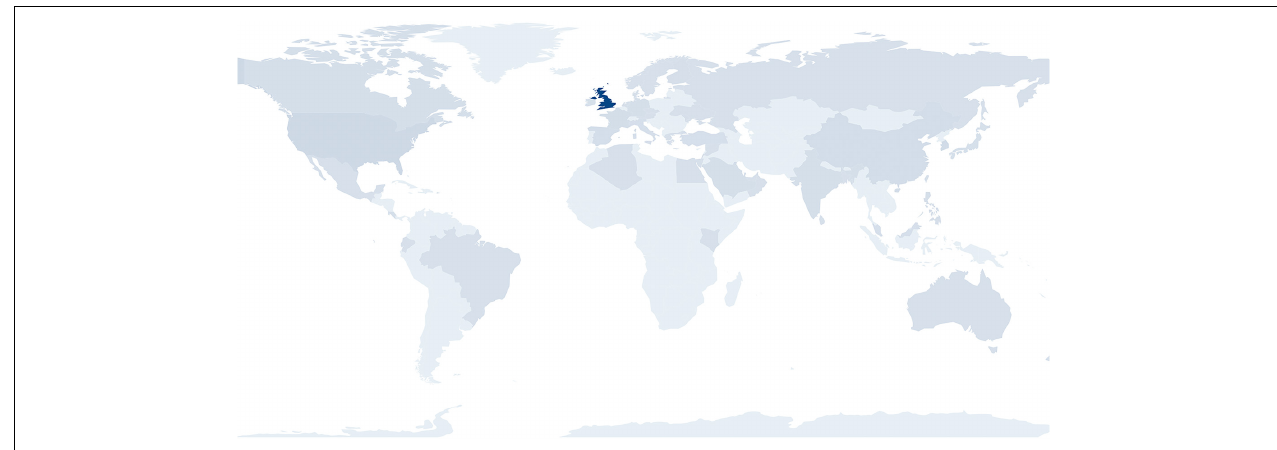
FIGURE 1 | Countries and regions of origin of visitors to the new COVID-19 web pages in the first year since launch. The intensity of shading relates to the proportion of total visits.